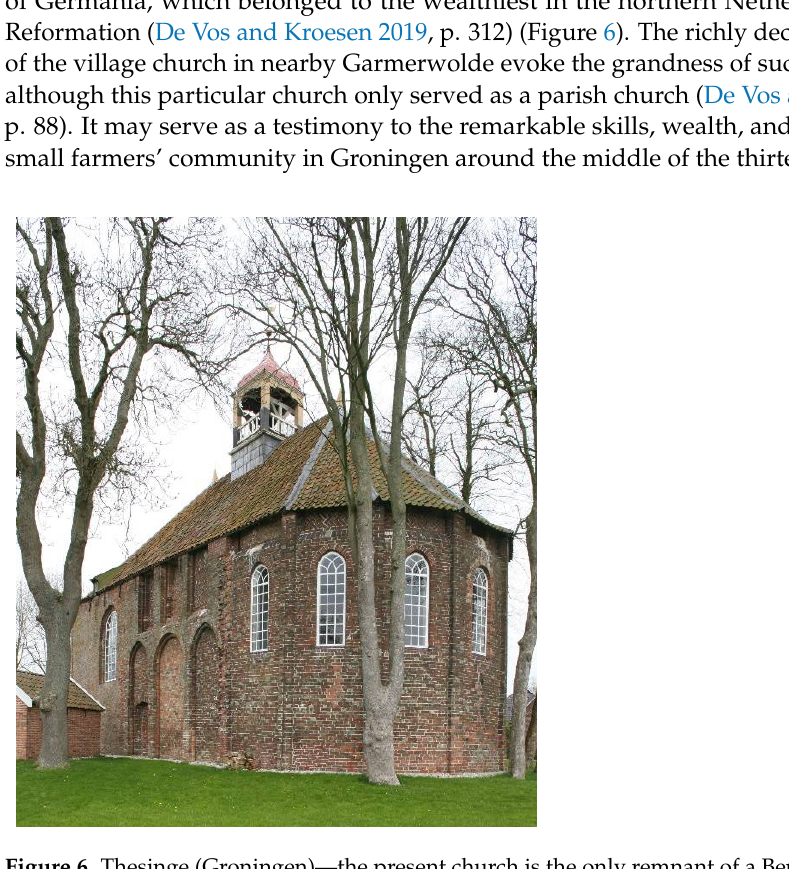
Figure 6. Thesinge (Groningen)—the present church is the only remnant of a Benedictine monastery church built in the late 13th century (photo: Regnerus Steensma archive). church built in the late 13th century (photo: Regnerus Steensma